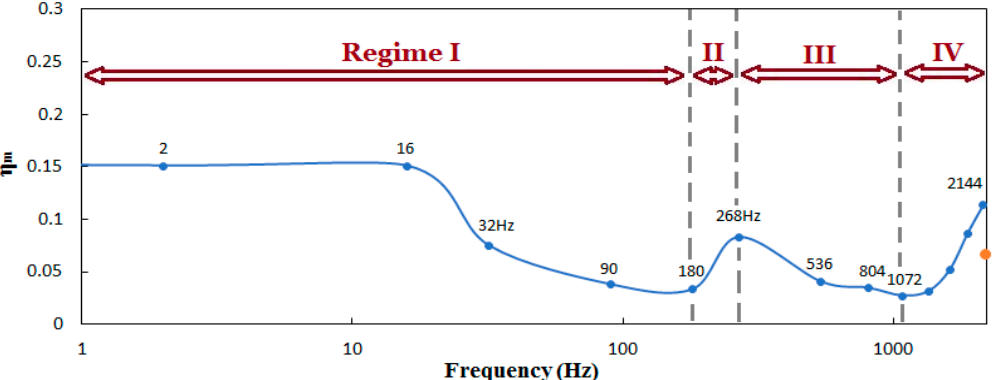
Figure 12. The variation of the spanwise-averaged effectiveness in terms of frequency (Hz) at X/D = 7 for M = 0.5 obtained by FLUENT, LES, Smagorinsky–Lilly model. The orange color point is the result for the multi-frequency unsteady flow. It represents the spanwise-averaged film cooling effectiveness when Equations (28) and (29) are used instead of individual frequencies [28].